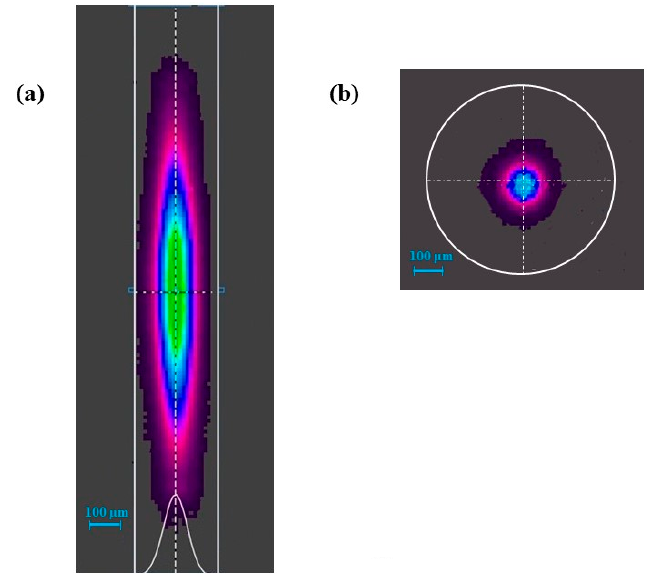
Figure 2. ( a ) Image of elliptical laser spot shaped by a Powell lens from a pyroelectric camera. ( b ) Image of circular light spot emitted by DFB laser from a pyroelectric camera.